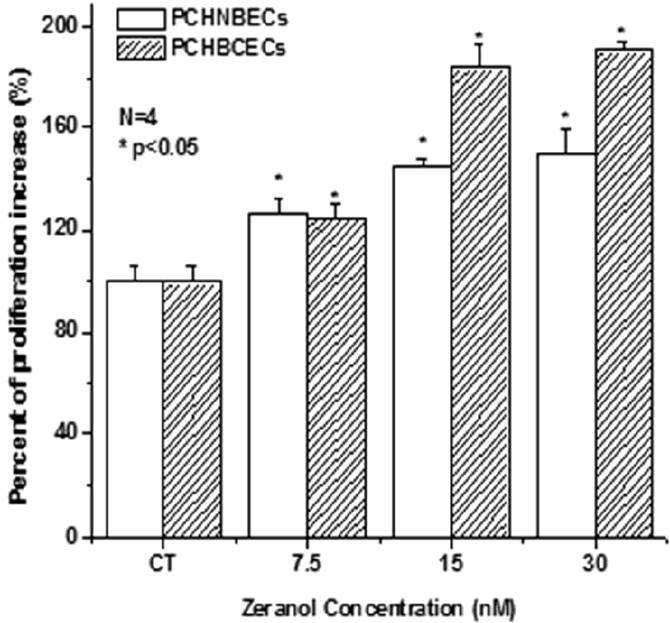
Figure 1. Effects of zeranol on the proliferation of PCHNBECs and PCHBCECs. PCHNBECs and PCHBCECs (5 × 10 3 cells/well) were treated with 0.1% DMSO (as